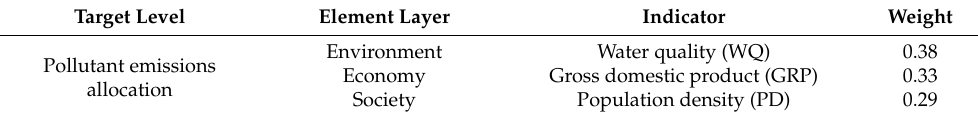
Table 3. Pollutant allocation indicator